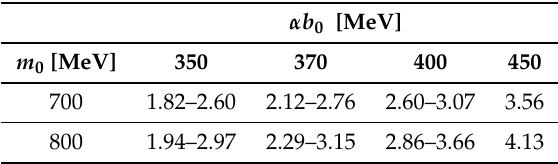
Table 4. Net-baryon density range of the coexistence phase of the chirally broken and restored phases in terms of saturation density units, ρ 0 , for different values of m 0 and α b 0 parameters. For the case of α b 0 = 450 MeV, the transitions are smooth crossovers for both values of m 0